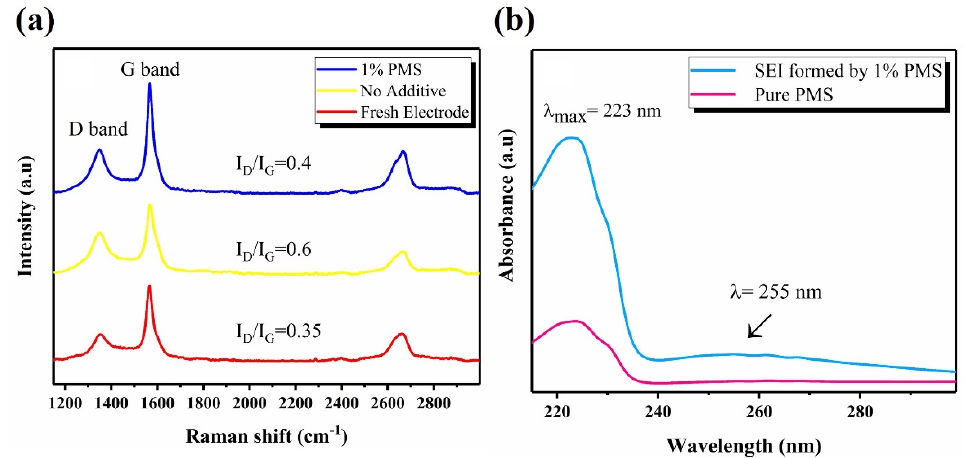
Figure 7. ( a ) Raman spectra obtained from the fresh and cycled graphite electrodes without and with PMS, ( b ) UV-visible spectra of PMS powder, and SEI formed on the graphite electrode through decomposition of PMS.